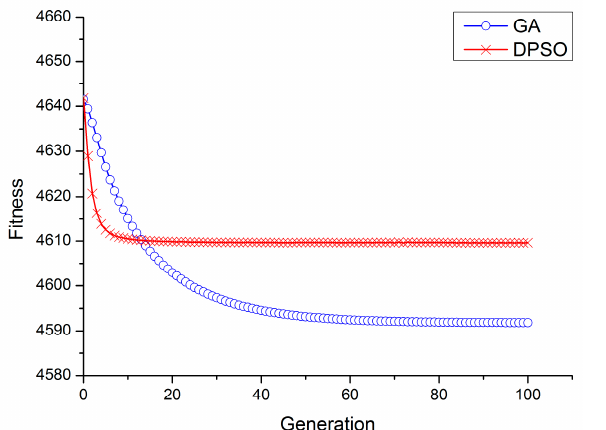
Figure 8. Fitness values of the GA and DPSO algorithm in 100 generations when n = 60 and m = 5.